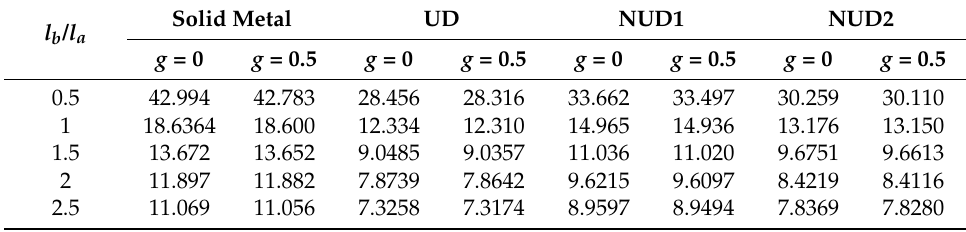
Table 6. The non-dimensional critical buckling loads with different aspect ratios, small scale parameters and porosity distributions of nanoplate ( m = n = 1, l a = 50 nm, h = 5 nm, ζ = 1, λ =